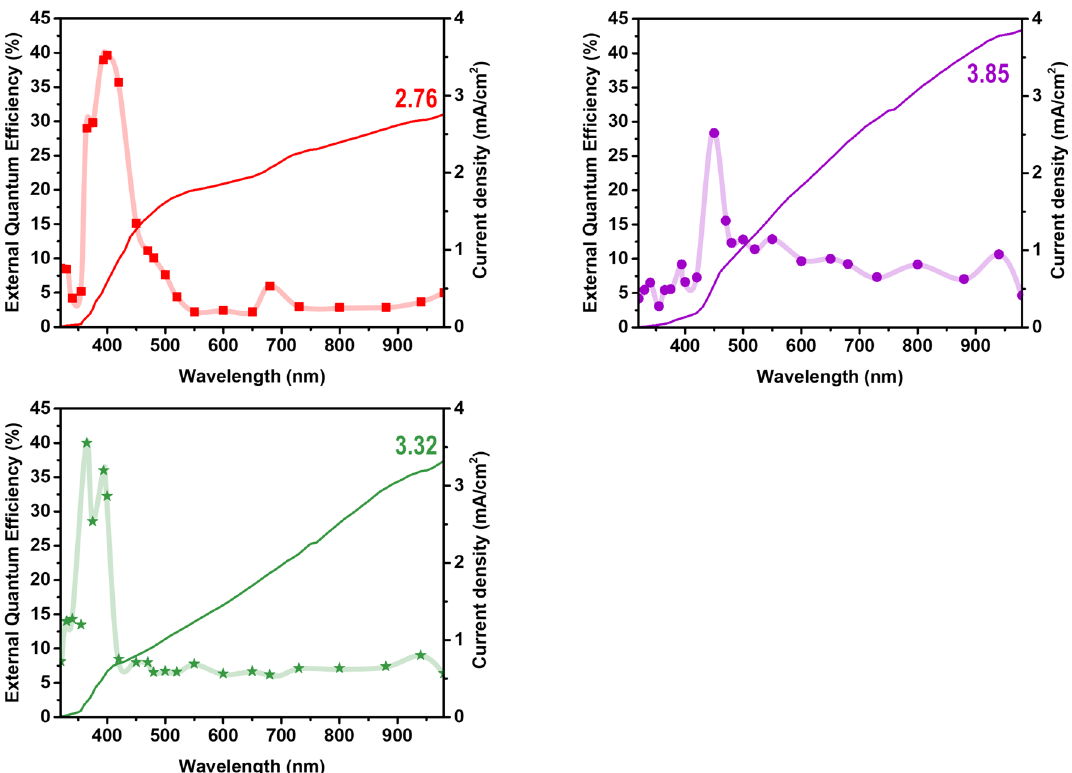
Figure 5. External quantum efficiency spectra of LSC systems with dye concentrations of C = 0.5 mg/ mL for RMC (red) and ZQD (purple) and RMC-ZQD (green) with 0.5 and 0.08 mg/mL at a size of 2.5 cm × 2.5 cm × 3 cm as a function of filters covering the 320–980 nm region 43 . The LSC had a single PV cell attached to one edge, with the other three edges painted black to block direct sunlight. The LSC device had a black background to prevent reflected light from entering from the rear of the device. In addition, light of other wavelengths was blocked so that only the light transmitted through the bandpass filter could reach the LSC. The EQE ( (cid:31) ) of the devices was calculated by Eq. (2) 44,45 : I LSC ( (cid:31) ) = EQE ref ( (cid:31) ) × (2) EQE ref where EQE ref ( (cid:31) ) and I PV are the EQE and short-circuit current of the silicon PV cell as a function of wavelength, respectively. T he short-circuit currents I LSC of the LSC device were measured under a solar simulator as a func- tion of wavelength. The spectrally resolved EQE ( (cid:31) ) of the LSC system as a function of wavelength is shown in Fig. 5. Current densities of 2.76 ± 0.05 mA cm −2 in the RMC LSC, 3.85 ± 0.05 mA cm −2 in the ZQD LSC, and 3.32 ± 0.05 mA cm −2 in the dual-dye RMC-ZQD LSC were obtained by integrating the EQE spectra. The inte- grated currents from the EQE were consistent within 10% differences with the values of 3.04 ± 0.01 mA cm −2 , 3.96 ± 0.05 mA cm −2 , and 3.49 ± 0.05 mA cm −2 extracted from the J–V characteristics in Fig. 4. To evaluate the reabsorption loss within the LSC waveguide, we compared the PV responses of the LSCs as a function of distance ( d ) between the PV cell and the excitation position (Fig. 6). The short-circuit current densities ( J SC ) of five LSCs with RMC, ZQD, and dual dyes (RMC-ZQD) were measured as a function of d . We fabricated a large LSC with dimensions of 7.5 cm × 10.0 cm × 0.3 cm and attached a silicon PV cell to the edge (7.5 cm × 0.3 cm). We used a mask so that a 2 cm × 2 cm area of LSC surface could be illuminated vertically at various positions from the Si PV cell. In the LSC containing 0.5 mg/mL of ZQD, as d increased, current density decreased exponentially, which is evidence of significant scattering and reabsorption losses. However, the LSC with RMC displayed a relatively constant J SC as a function of d , indicating little reabsorption. In the dual-dye LSC with 0.5 mg/mL of RMC and 0.08 mg/mL of ZQD, current density increased due to the addition of ZQD, though it was constant as a function of d . When the concentration of ZQD was increased to 0.5 mg/mL in dual- dye system, rapid current decrease was observed as a function of d , but the reduction rate in d beyond several centimeters was not severe compared with that of the LSC with 0.5 mg/mL of ZQD alone indicating suppressed scattering effect by aggregated nano particles of ZQD. Although the PCE of an LSC containing 0.5 mg/mL of ZQD alone was as high as that of the dual-dye system, the exponential current–density decreased as a function of d make them unsuitable for practical application of large LSCs. The significant suppression of the reabsorption loss observed in the dual-dye LSC appeared to be due to uniform dispersion of RMC anions [Re 6 S 8 (NCS) 6 ] 4− along